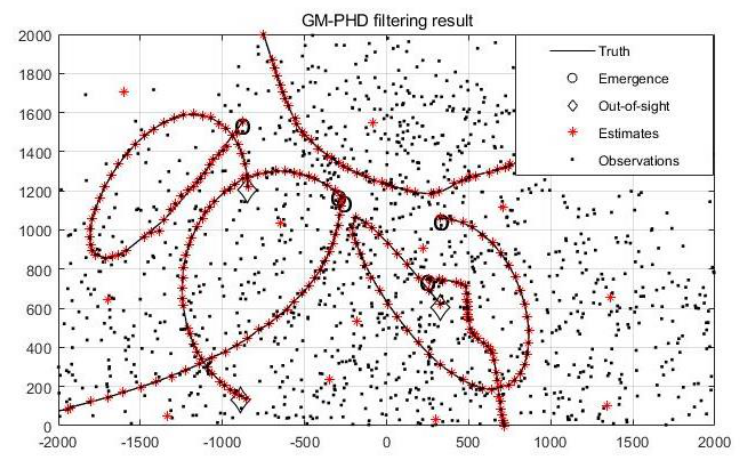
Figure 4. GM − PHD filter results.